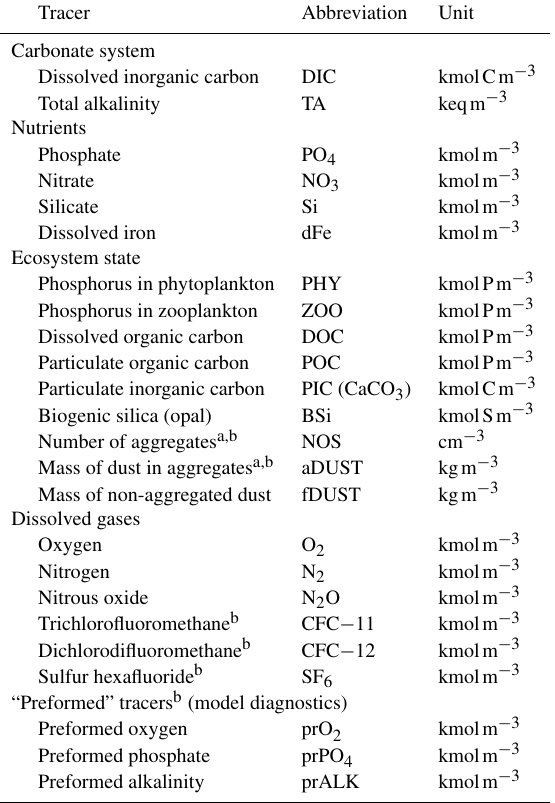
Table 1. Prognostic biogeochemical tracers in